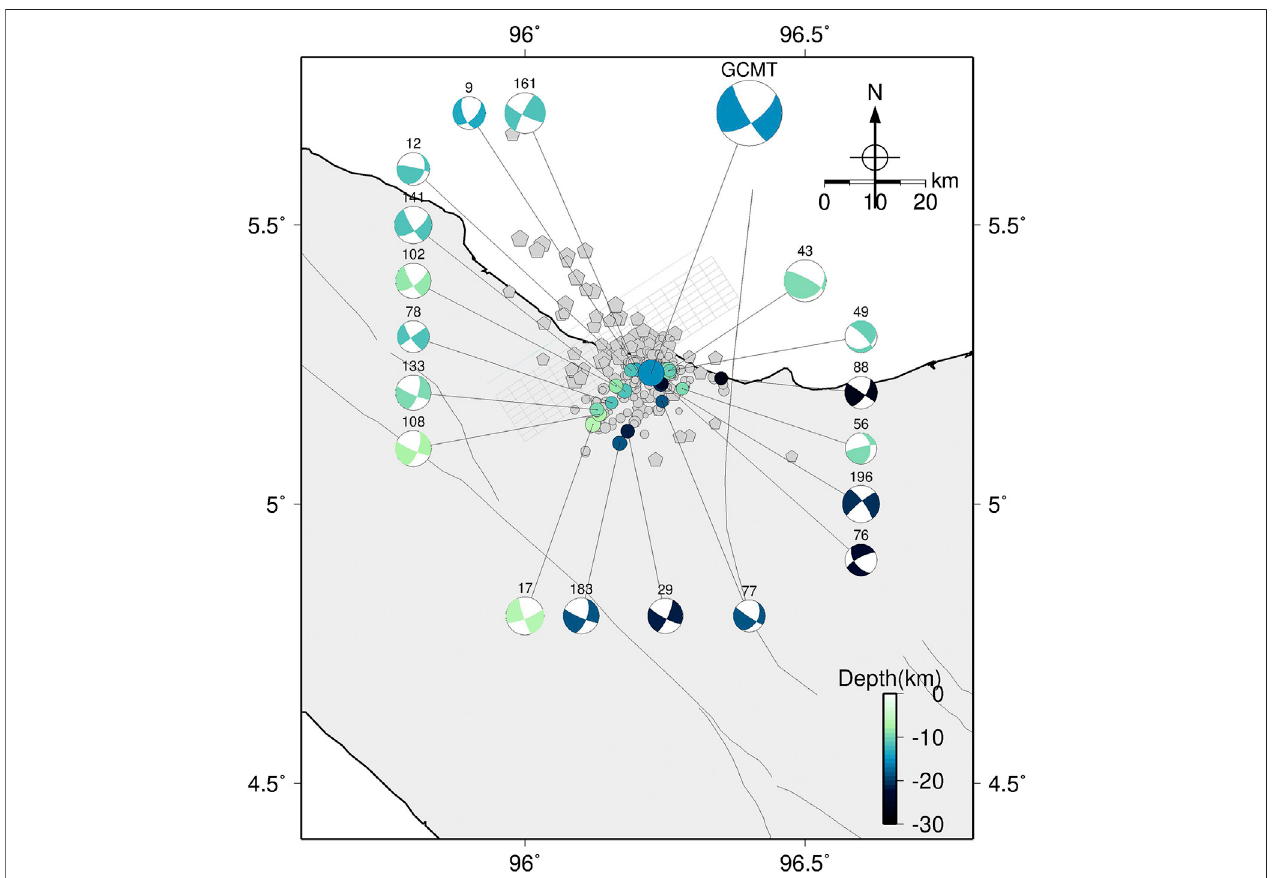
FIGURE5| Events,focalmechanisms,andslipmodelgrid(greenandbluelines)ofthe2016PidieJayaaftershocksusedinthisstudyrefertotheresultsofSupendi et al. (2017), Muzli et al. (2018), and Rusli (2017).